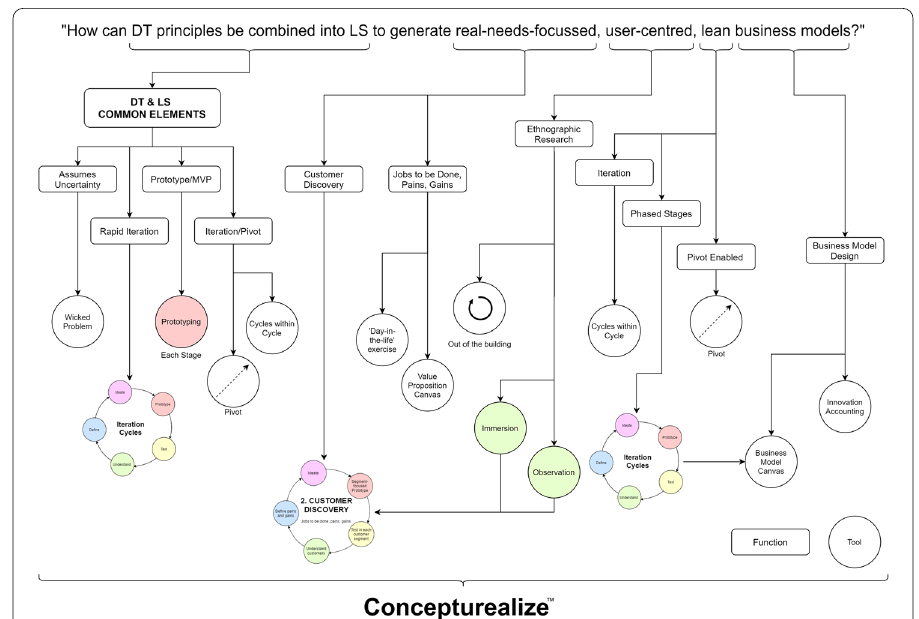
Fig. 5 Concepturealize ™ functions and core